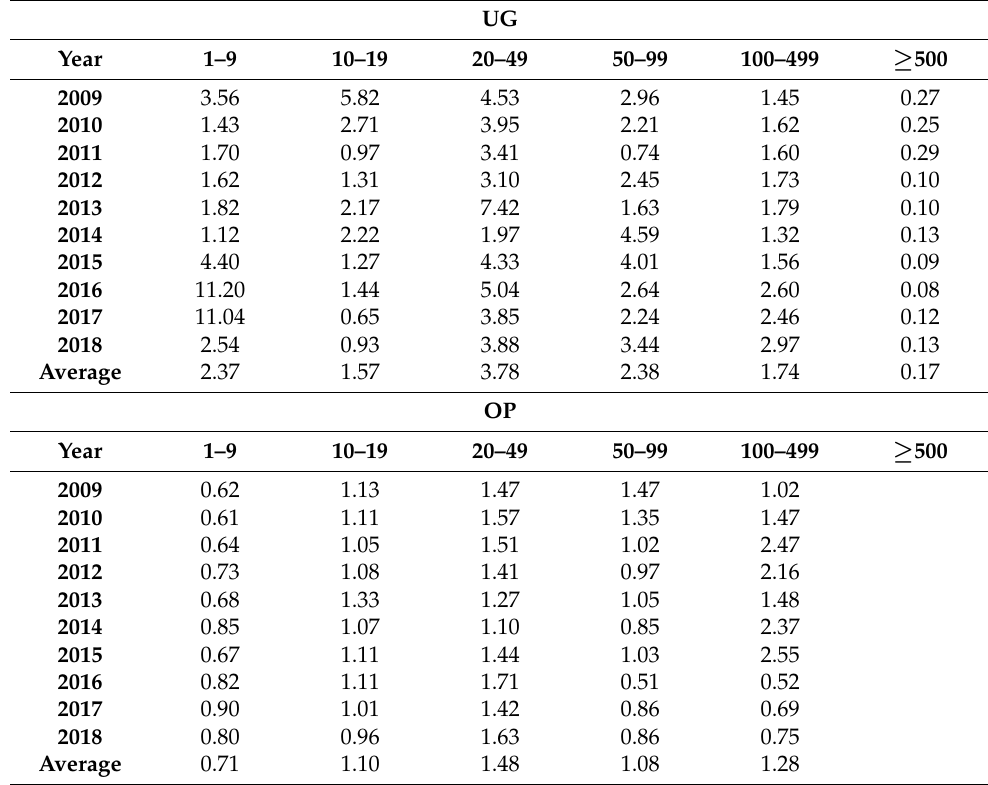
Table 7. Incidence risk index per size and each